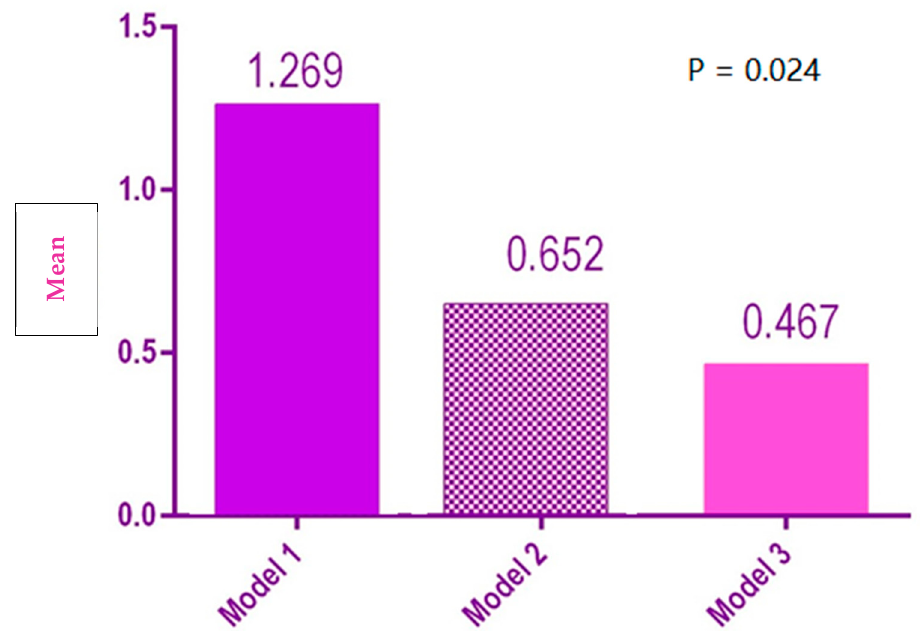
Figure 11. Statistical results of mesial-distal distances for the 3 models. There was no significant difference between the three models regarding the average of the external distances of the dental arch Figure 12).